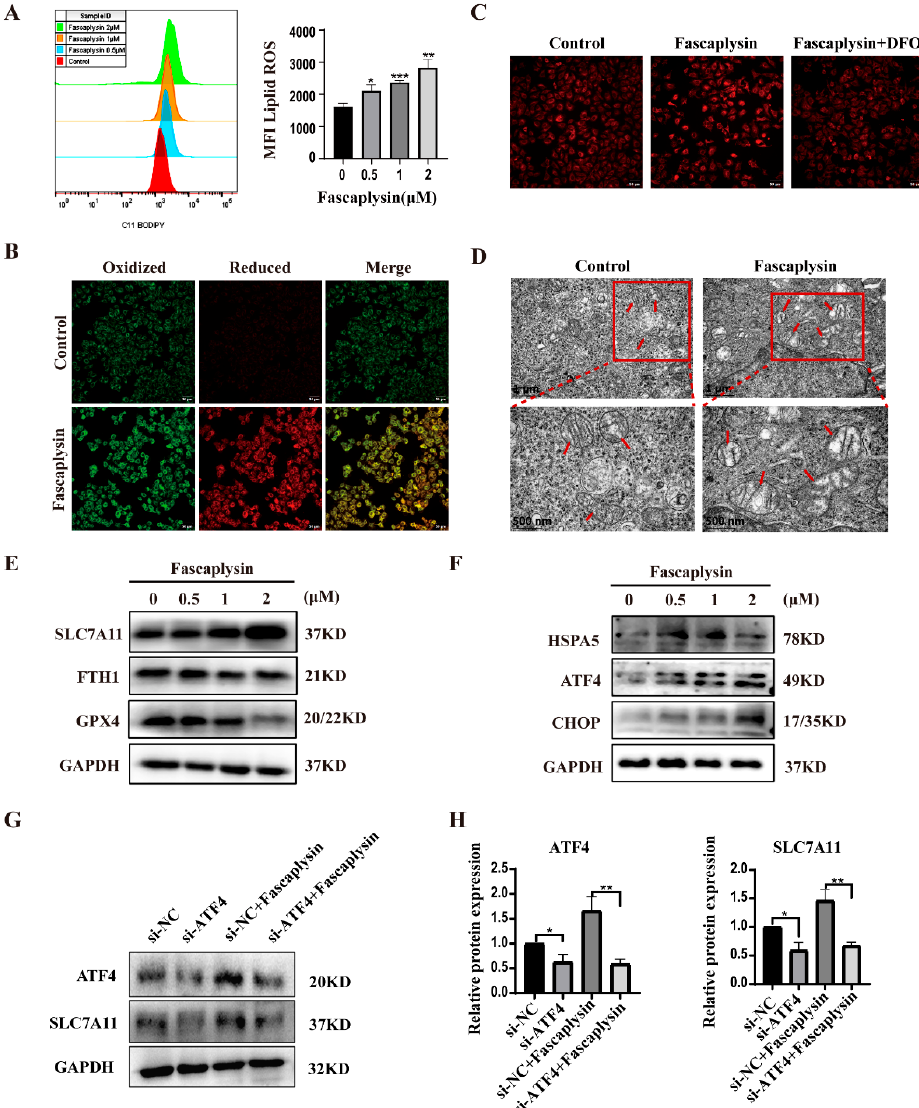
Figure 4. Fascaplysin induced ferroptosis and ER stress in A549 cells. ( A ) Representative images and statistical results of lipid ROS in A549 cells. ( B ) Fluorescence images of lipid peroxidation in A549 cells were observed using a C11-BODIPY-581/591 probe. ( C ) A549 cells were treated with fascaplysin (2 μ M) and DFO (50 μ M) for 3 h, and fluorescence images of cellular Fe 2+ were detected using a Ferrorange probe. ( D ) Intracellular mitochondrial morphological changes in A549 cells were observed by transmission electron microscopy (TEM) (original magnification: 6000×, 80,000×). Red arrows indicate mitochondria ( E ) Ferroptosis-related proteins were detected by Western blotting. ( F ) ER stress-related proteins were detected by Western blotting. ( G , H ) A549 cells were transfected with si-ATF4 (20 nM) for 60 h and treated with fascaplysin for 3 h. ATF4 and SLC7A11 protein expression was then detected by Western blotting. Analysis results represent mean ± SD, * p < 0.05, ** p < 0.01, and *** p < 0.001.